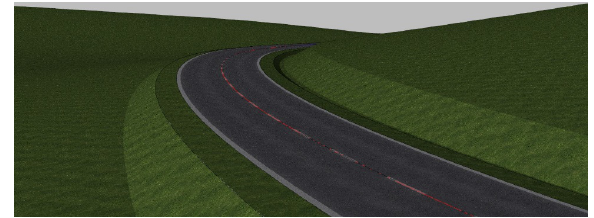
Figure 7. Road with slopes, 3D model.